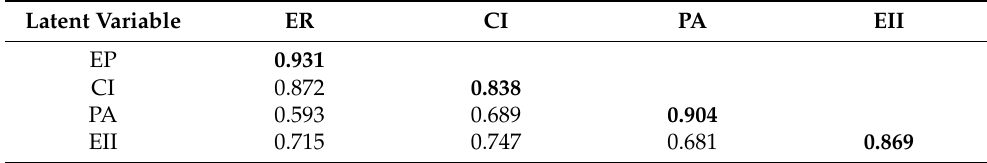
Table 1. Square root of the AVE and the correlation